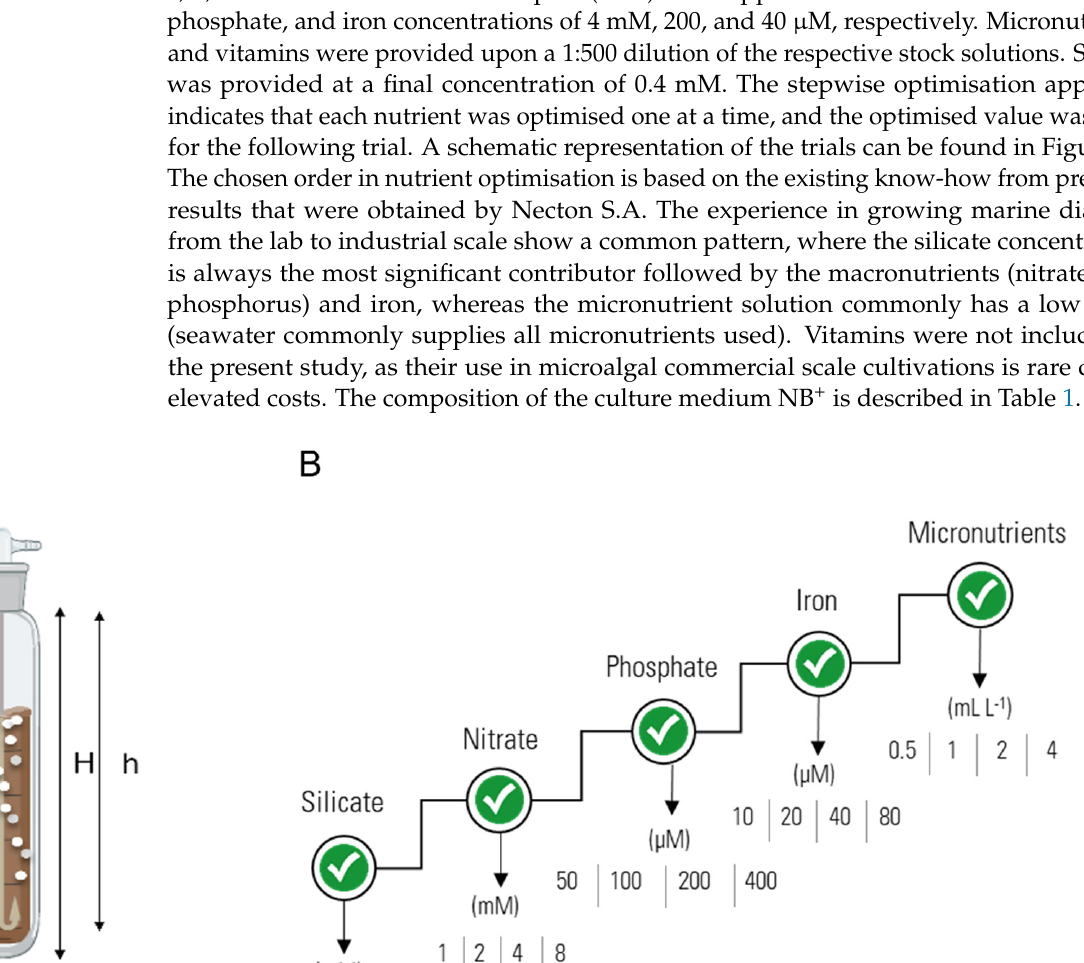
Figure 1 . ( A ) schematic representation and dimensions of the bubble columns PBRs system that was used in nutrient optimisation trials. H, column height: 43 cm; h, draft tube height: 41 cm; D, column diameter: 6 cm; d, draft tube diameter: 1 cm. ( B ) schematic representation of the stepwise optimisa- tion process that was applied in the present work. Each nutrient was optimised individually regard- ing four different concentrations. The optimised concentration was employed in the following step of nutrient optimisation.